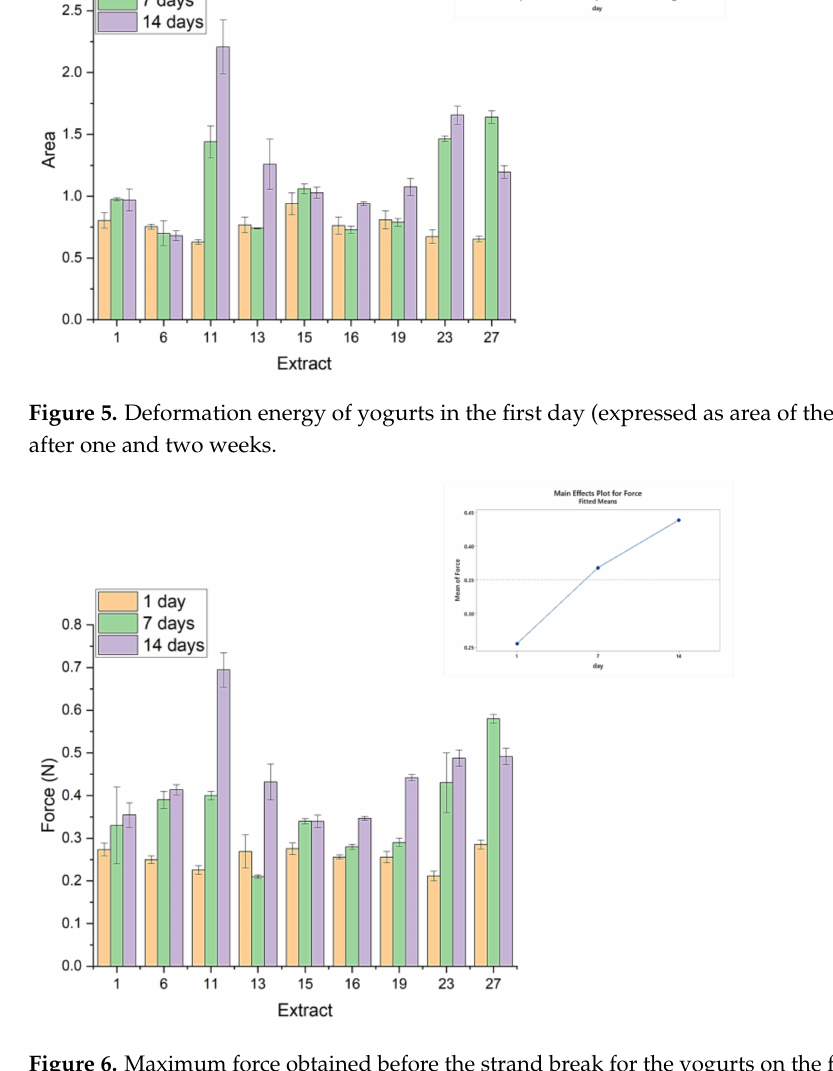
Figure 6. Maximum force obtained before the strand break for the yogurts on the first day, as well as after one and two